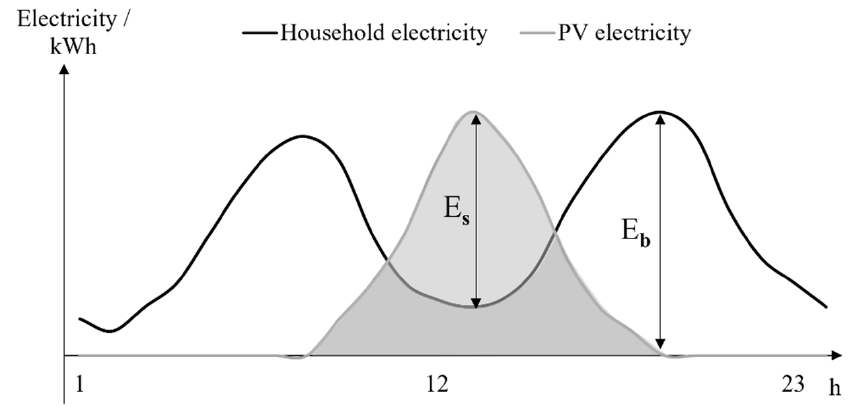
Figure 5. Example of the household electricity use and supply of a household. The curves difference represents bought and sold electricity. E s and E b stands respectively for electricity surplus and electricity that needs to be bought for each hour.